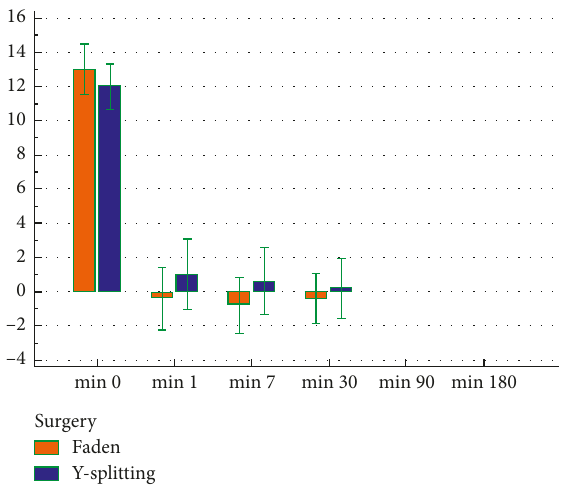
Figure 5: Preoperative and postoperative minimum strabismus angles in both